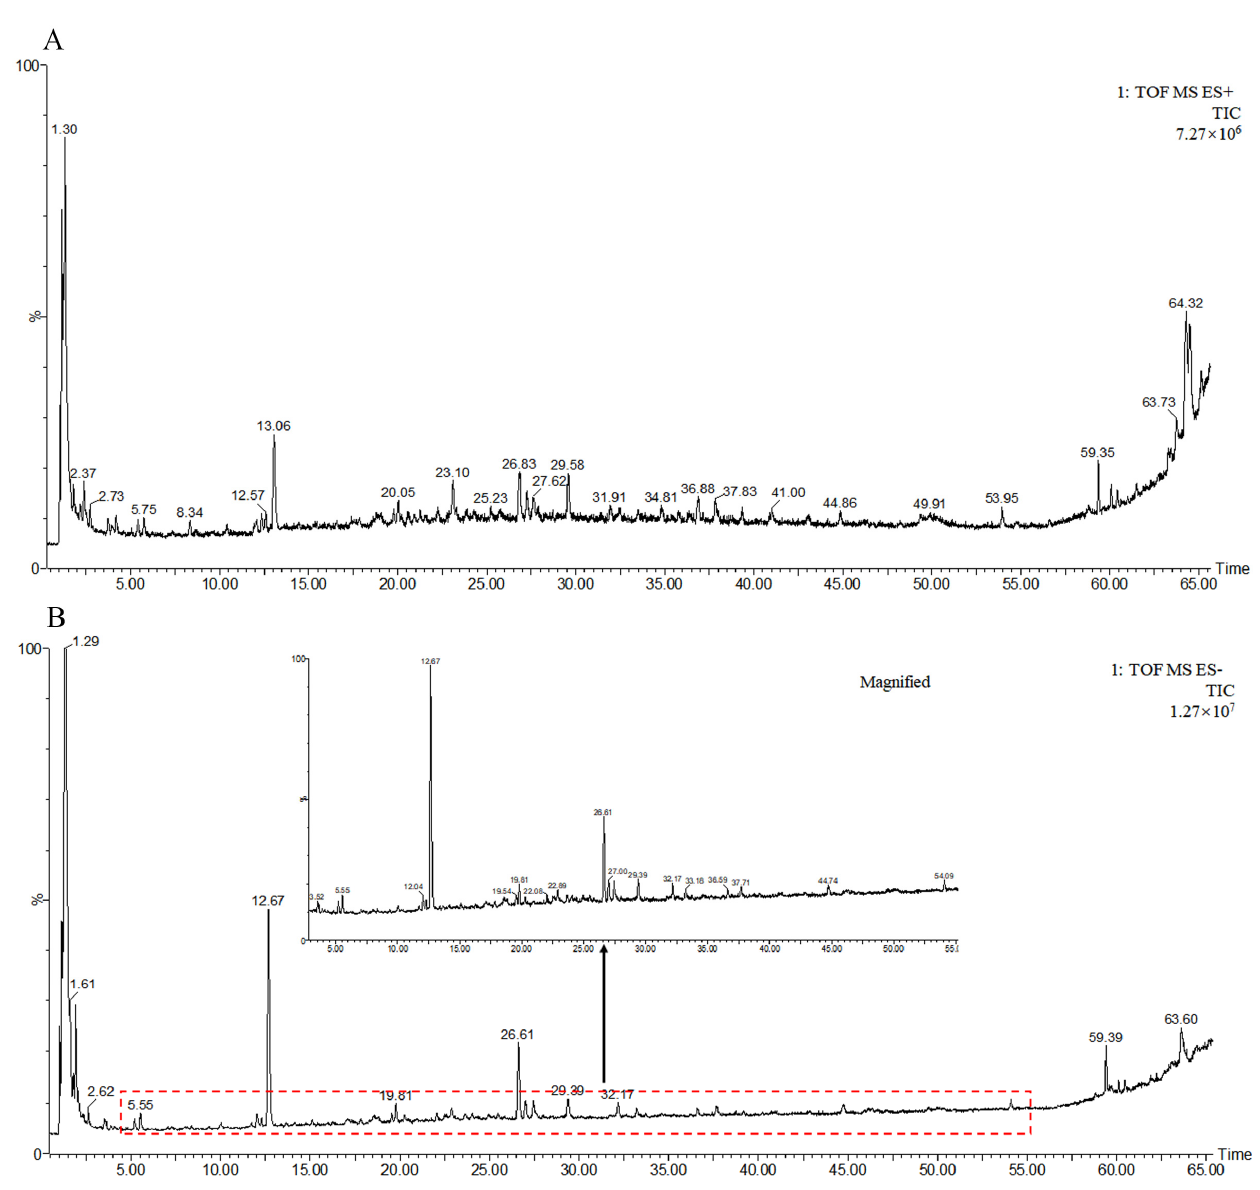
Figure 1. The total ion chromatograms of AS aqueous extract in positive ( A ) and negative ( B ) ion